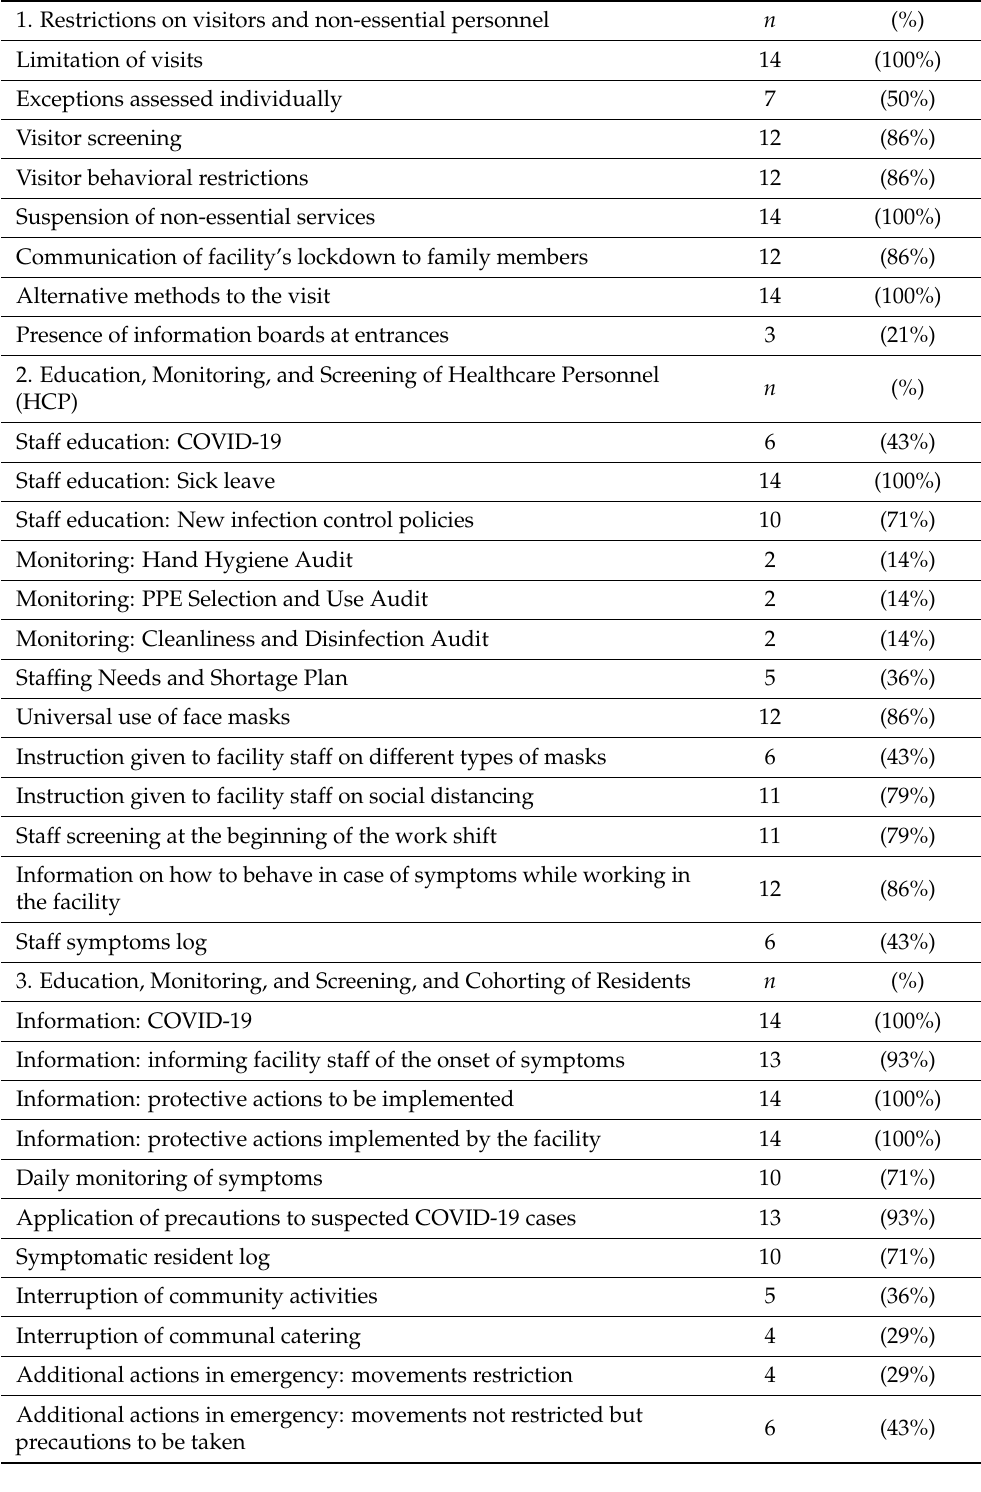
Table 5. Application of checklist procedures in residential facilities for elderly people in the city of Sassari ( N =